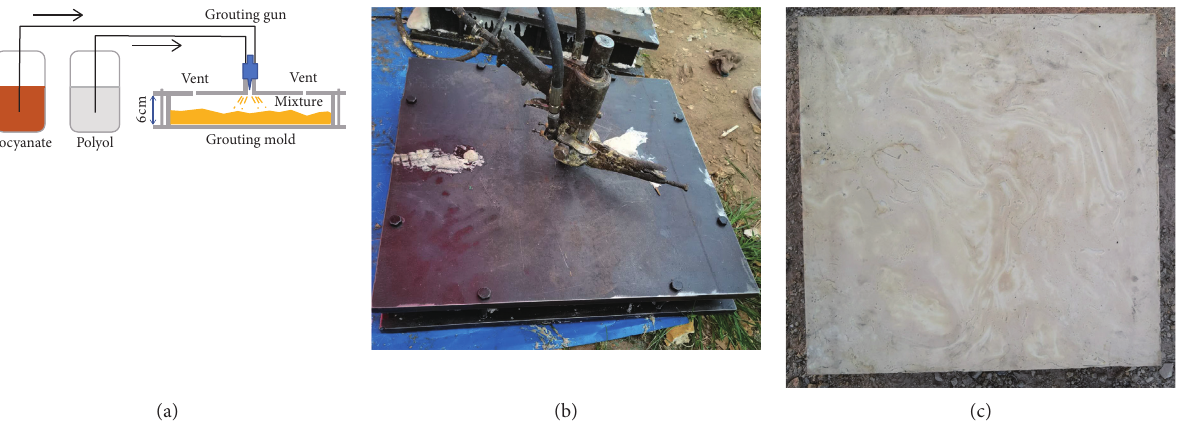
Figure 1: The preparation process of the specimens. (a) Grouting. (b) Grouting completed. (c) Specimens.